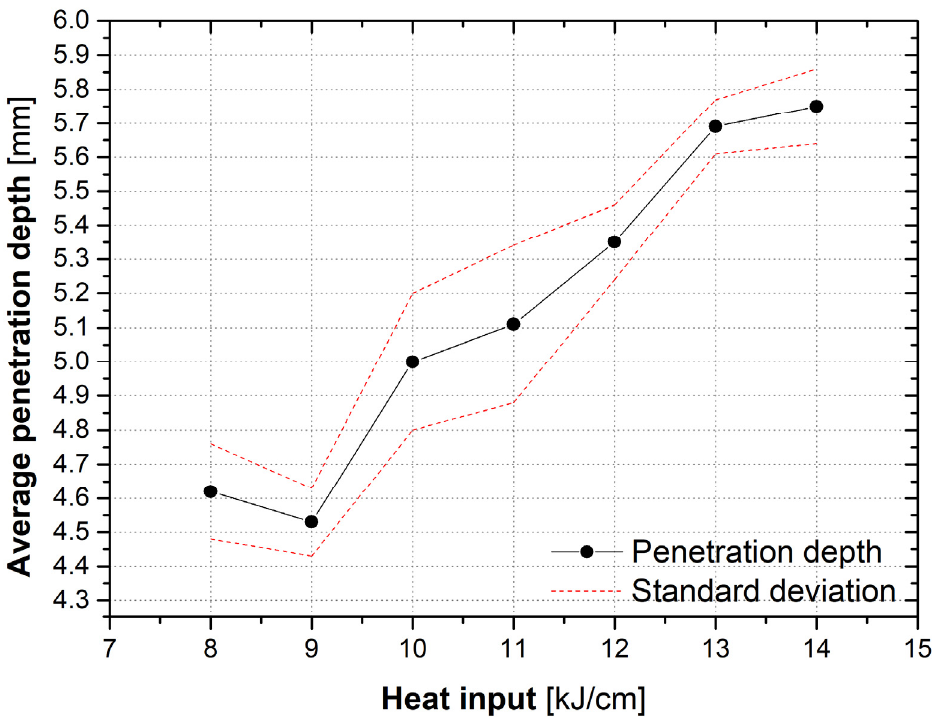
Figure 6. Penetration depth vs. heat input value.